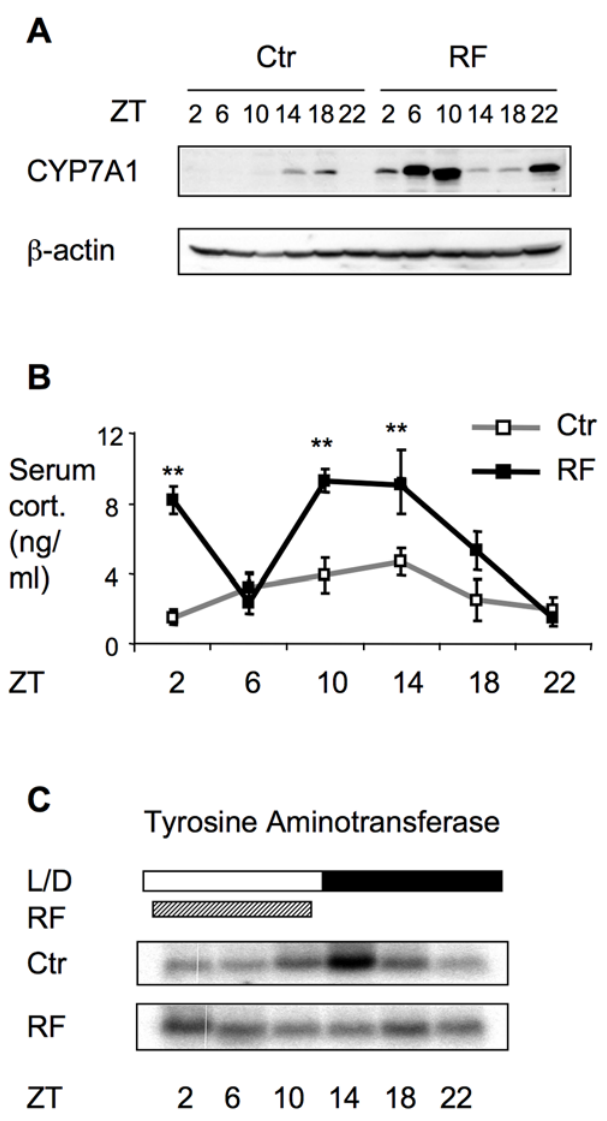
Figure 2. Expression of Cyp7A1 and its correlation with circulating corticosterone level. A. Circadian expression of Cyp7A1 protein level is reversed by restricted feeding as shown by Western analysis. Each time points represents pooled sample of 3–4 mice. B. Circadian variation of serum corticosterone level in control and restricted fed mice. Values are expressed as mean 6 SEM and n=3–4 for each time point. **: p , 0.01. C. Expression of tyrosine aminotrans- ferase corresponds to circadian variation of serum corticosterone in Ctr and restricted fed groups as shown by Northern analysis.